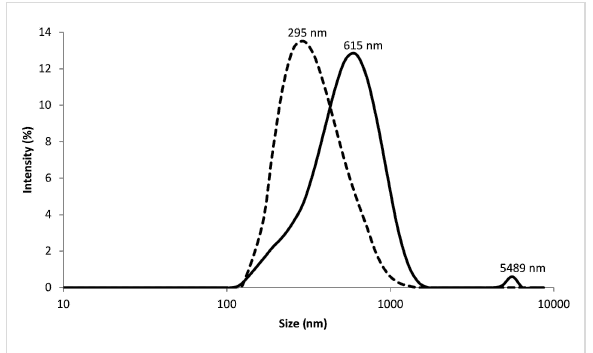
Figure 6: DLS measurements of α -CD-disiloxane 4 (A) (dashed line) and the supramolecular formation of α -CD-disiloxane 4 with ferrocene (B) (solid